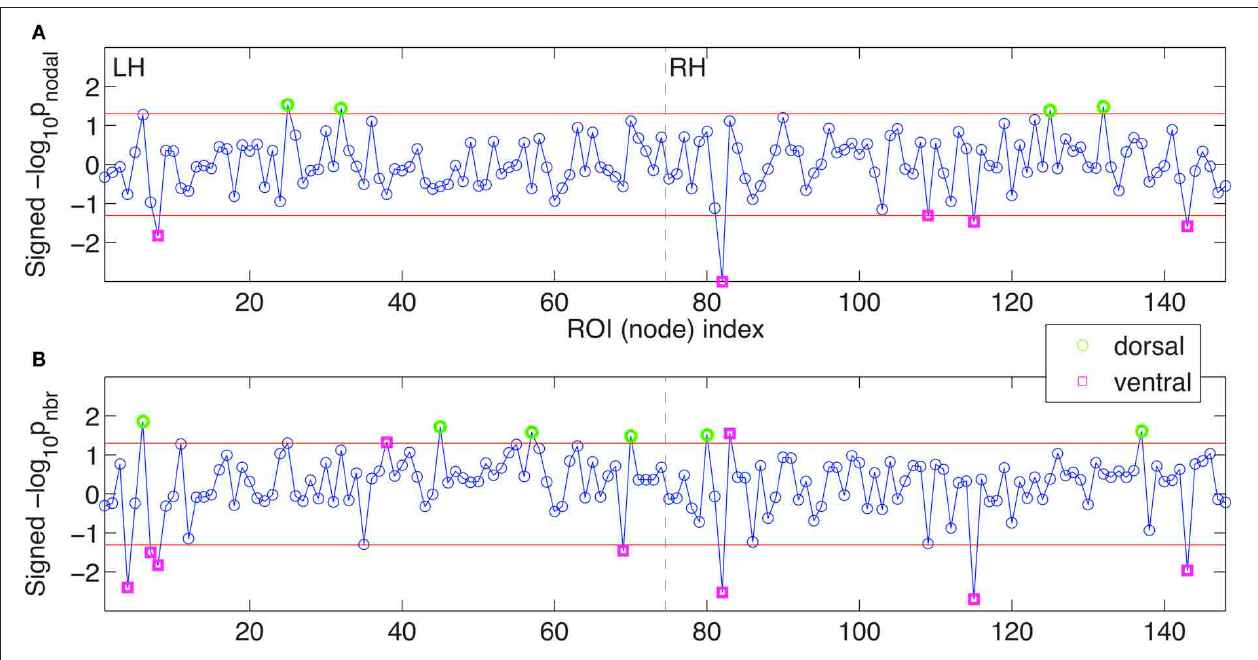
FIGURE 7 | The mean node-level efficiency measures were compared. Signed logarithmic p -values for nodal efficiency (A) and for neighboring efficiency (B) are given. The x-axis indicates the index of the ROI, or the node, from the left hemisphere (LH) to the right hemisphere (RH), which are separated by dashed vertical lines. Along the y-axis, the positive values mean the higher